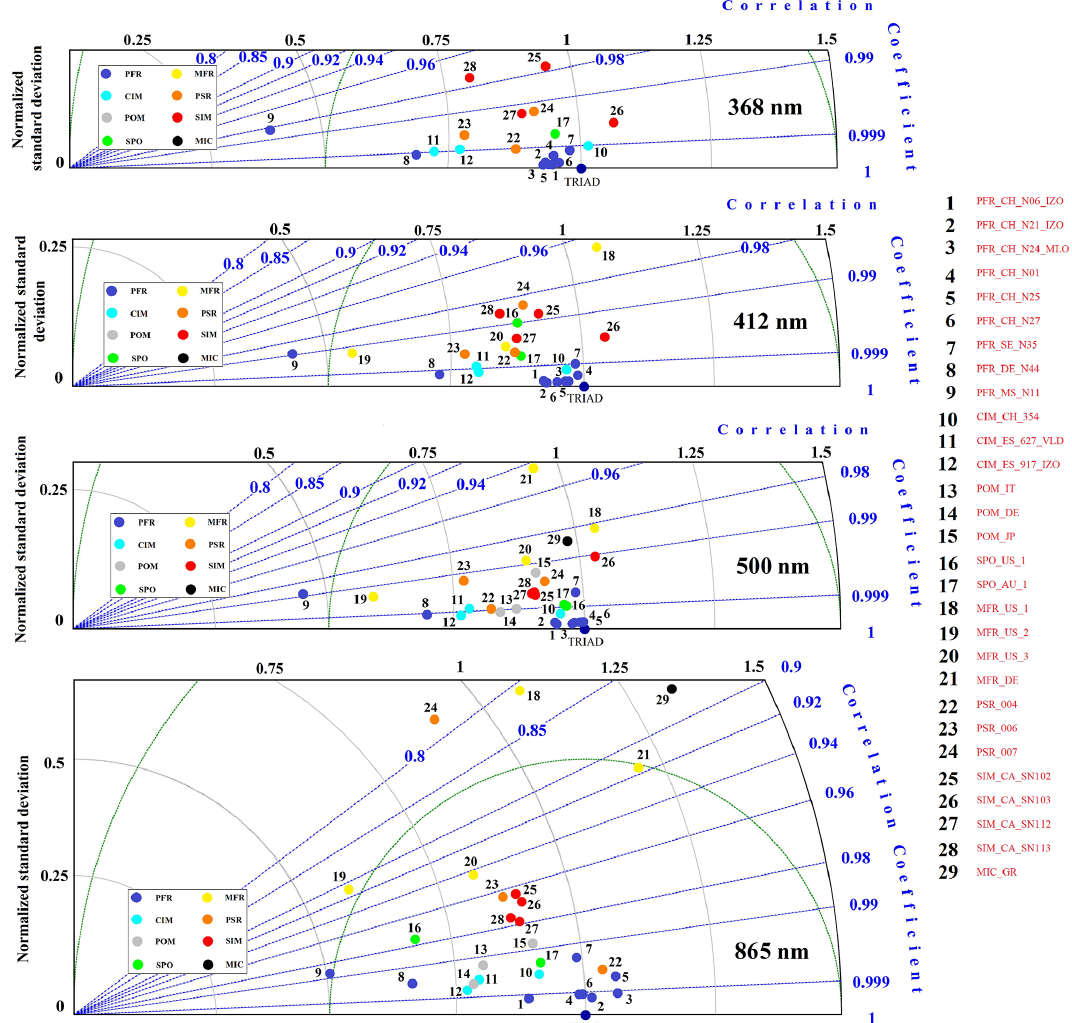
Figure 4. Taylor diagrams at the four measuring